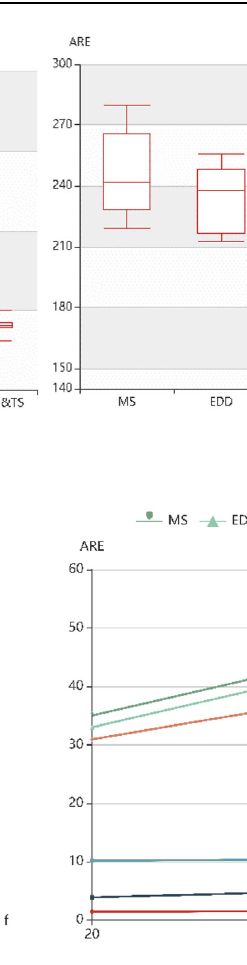
Fig. 7 ARE with different numbers of jobs